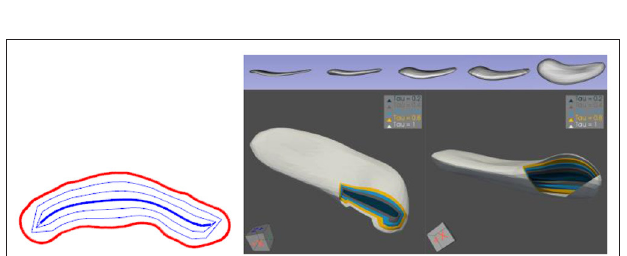
FIGURE 4 | Left: Radial onion skins in 2D. Right: Onion skins at τ 2 = 0.0, 0.2, 0.4, 0.6, 0.8, and 1.0 (boundary) for a hippocampus; top row: individual onion skins for the various τ 2 values. Bottom row: two views of those onion skins seen end-on for a cut through the